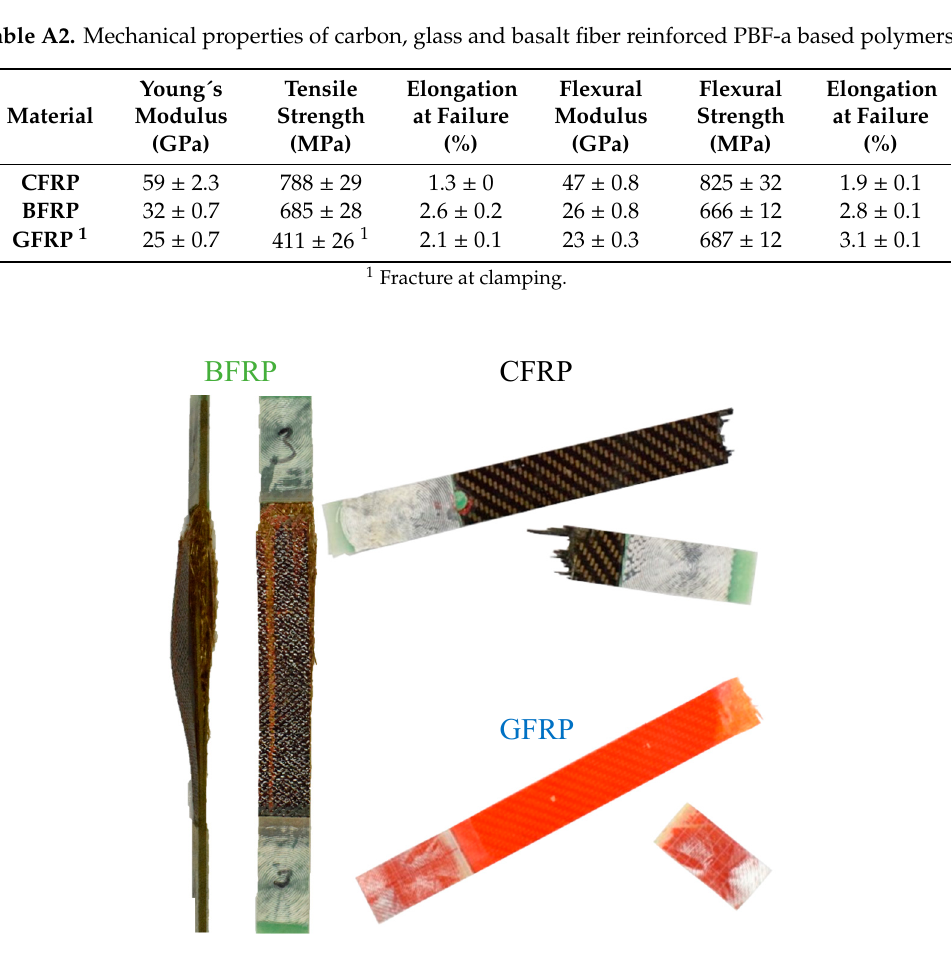
Figure A1. Fracture patterns of carbon, glass and basalt fiber reinforced PBF-a after tensile testing.